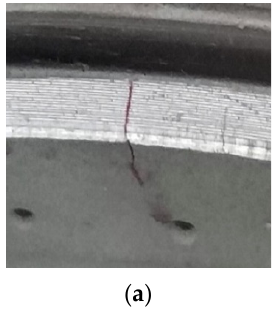
Figure 5. Types of defect. ( a ) Crack; ( b ) gap; ( c ) pit; ( d )